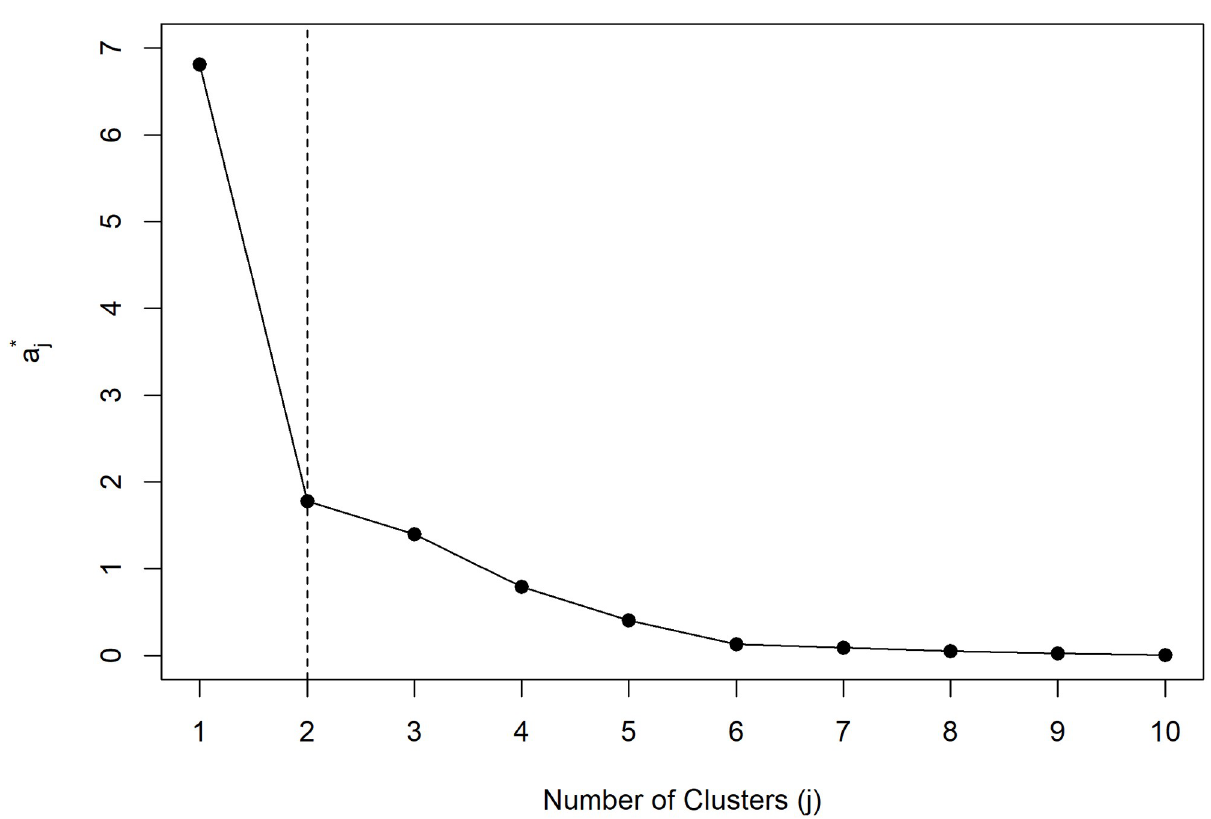
Fig 10. Plot of the Mojena’s statistics as a function of the number of clusters.